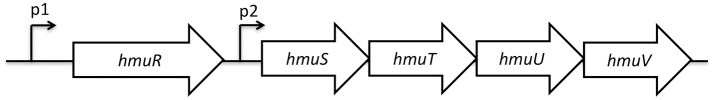
Genetic structure of the hmuRSTUV genetic locus. The promoter upstream of hmuR is denoted as p1, while the intergenic promoter between hmuR and hmuS is denoted at p2.